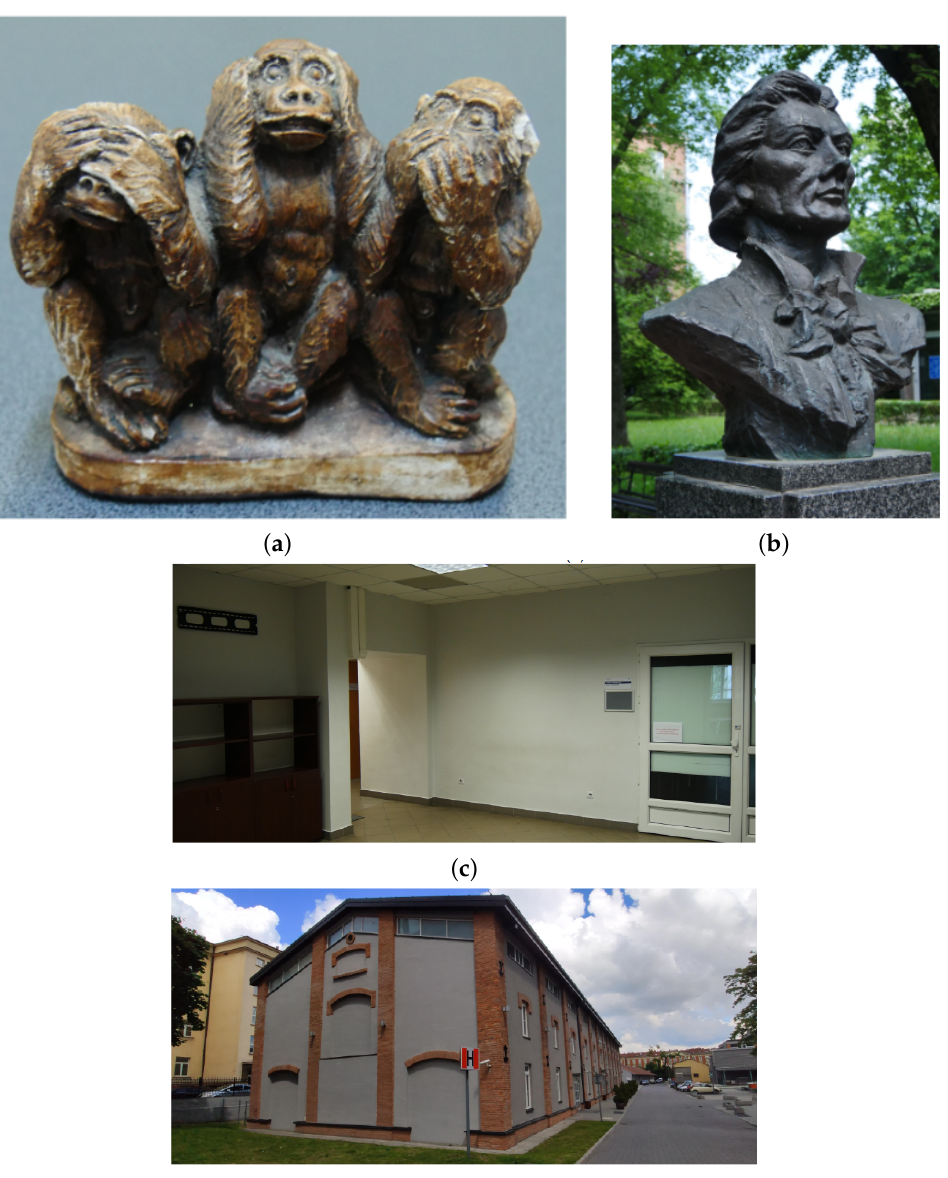
Figure 2. Objects at various scales used during the study: ( a ) fine detail; ( b ) small architecture object; ( c ) room interior; ( d ) building